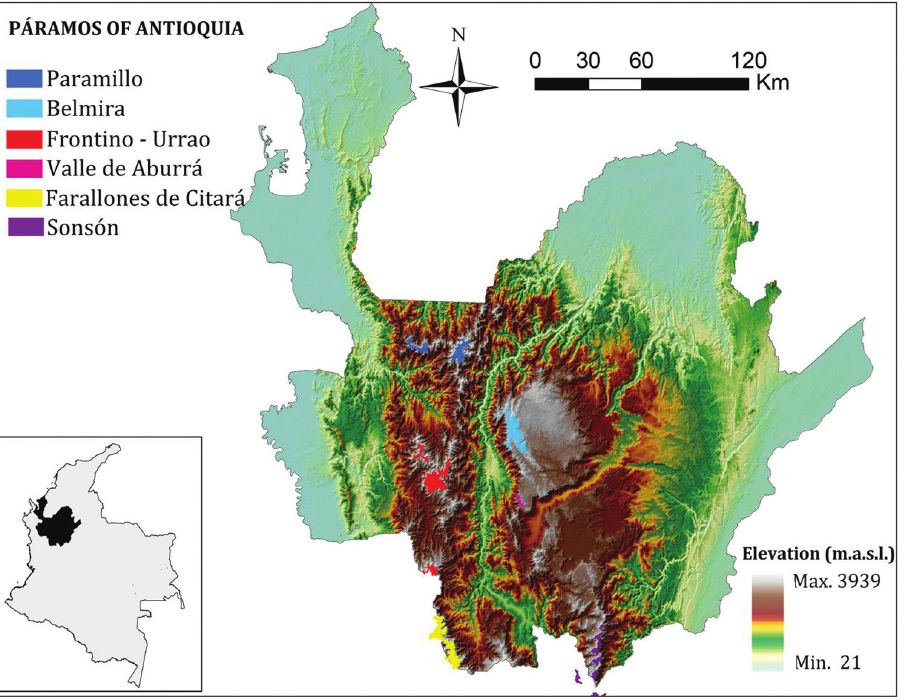
Figure 1. Geographic location of the páramo complexes of